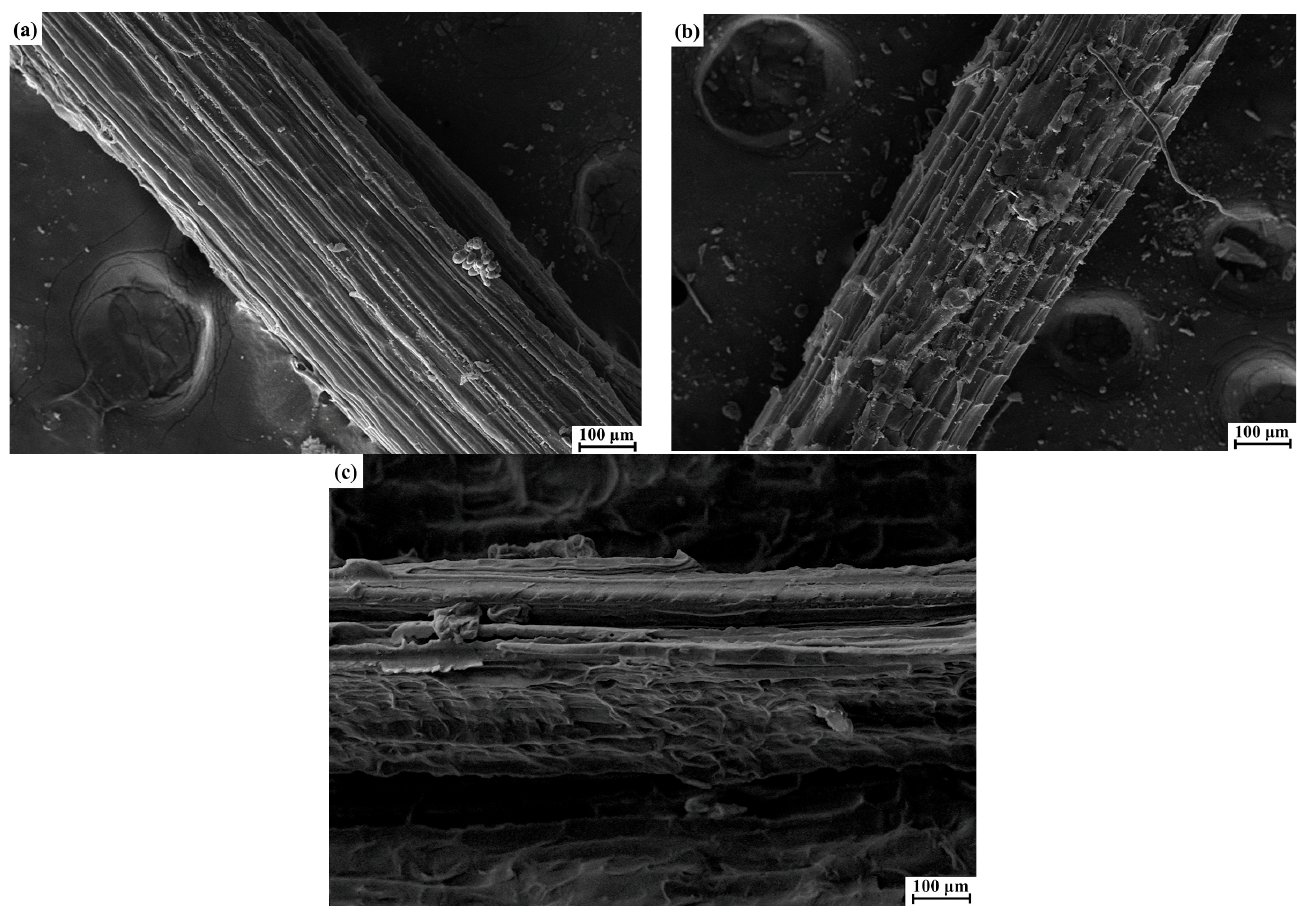
Figure 2. SEM images of the ( a ) CSF, ( b ) CDF, and ( c ) SF.